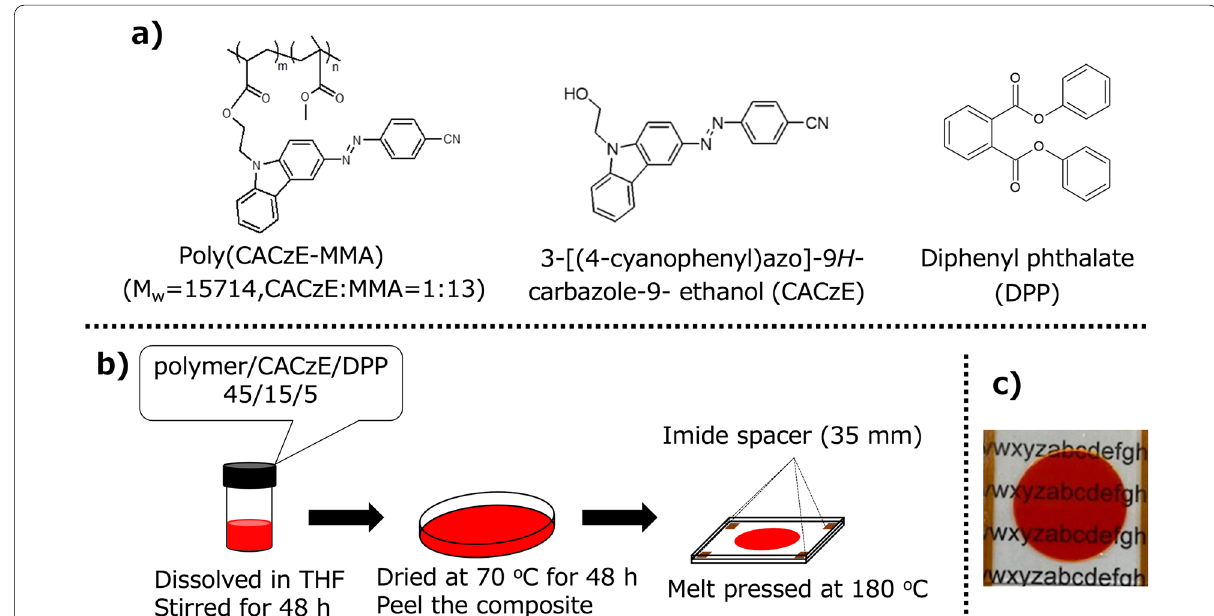
Fig. 3 a Chemical structure of the materials used for sample preparation, b (left to right) the three steps involved in the polymer film fabrication and c photograph of the fabricated sample placed on top of printed alphabets, showing good